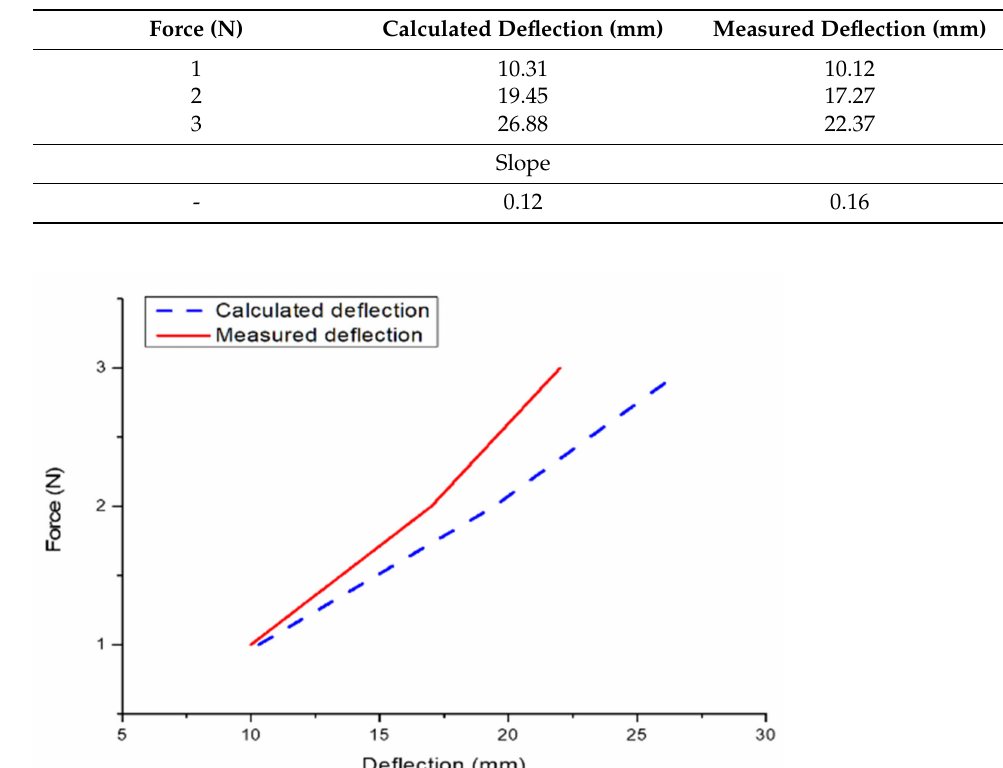
Figure 13. Comparison of the variation of the predicted and measured deflection with applied force.